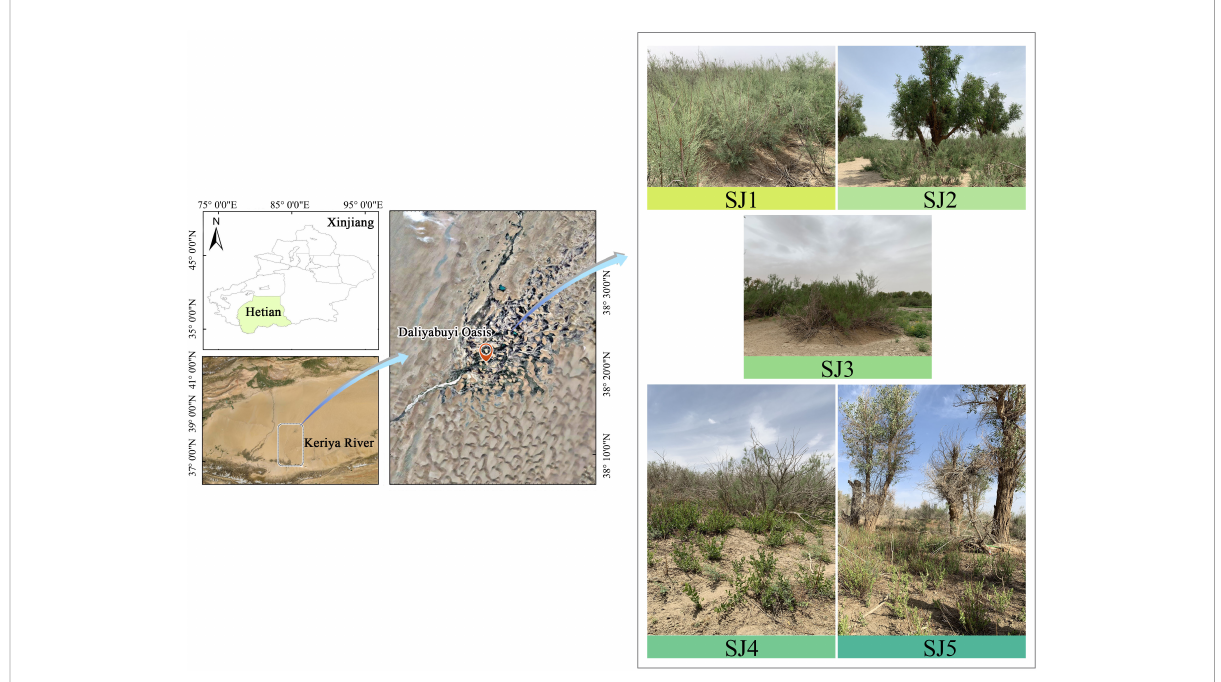
FIGURE 1 Study area location in Xinjiang, China. The abbreviations of the different habitats are as followed: T. chinensis population (SJ1), T. chinensis - P. euphratica (SJ2), T. chinensis - S. alopecuroidies (SJ3), T. chinensis - K. caspia - A. sparsifolia (SJ4), T. chinensis - K. caspia - A. sparsifolia - P. euphratica